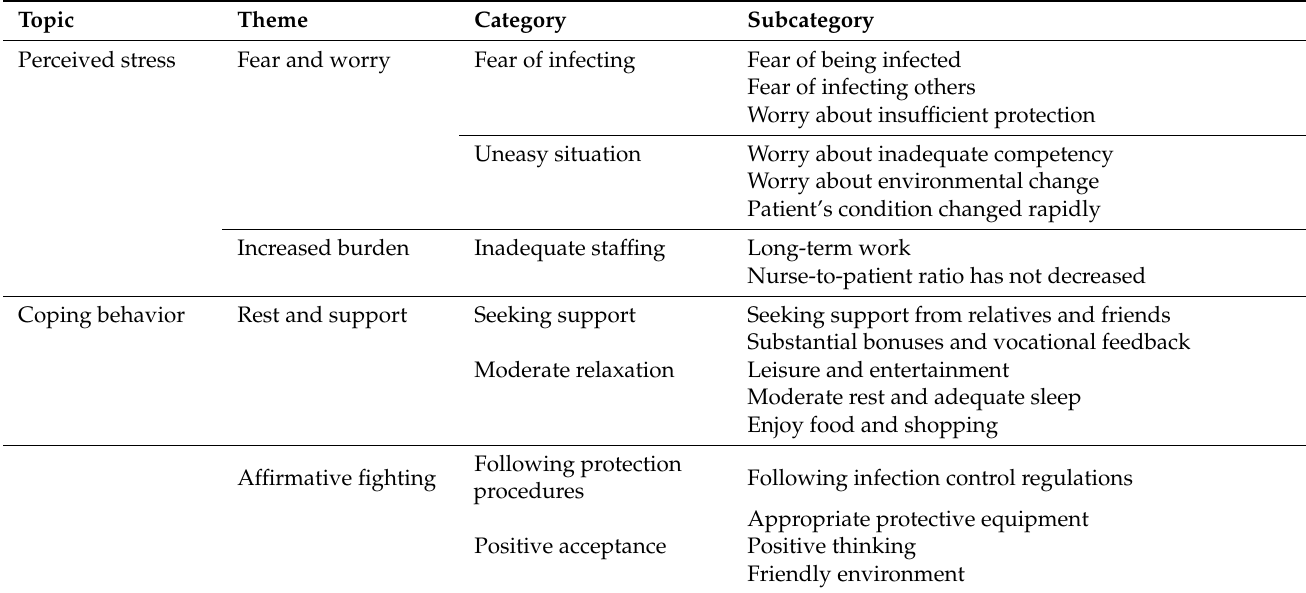
Table 4. The results of the qualitative data analysis presented as themes, categories, and